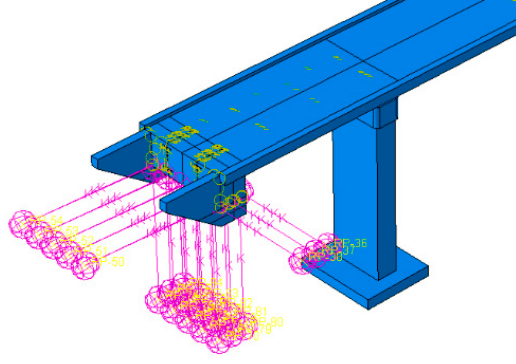
Figure 12. Boundary conditions for the SPRING_Ovhg.